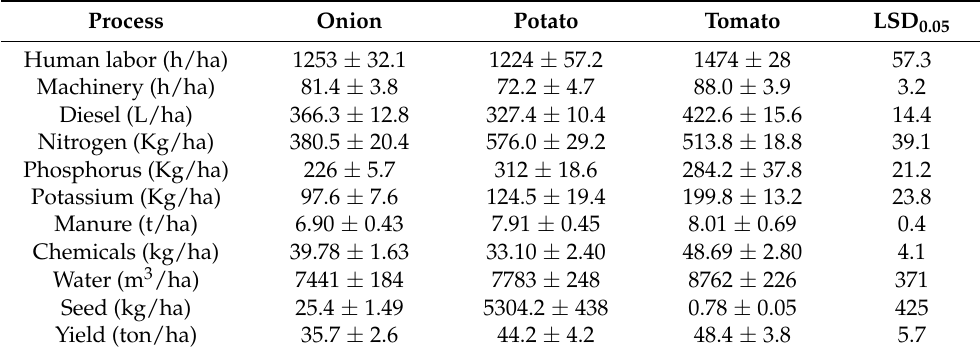
Table 1. Number of inputs and outputs of production processes for onion, potato and tomato.